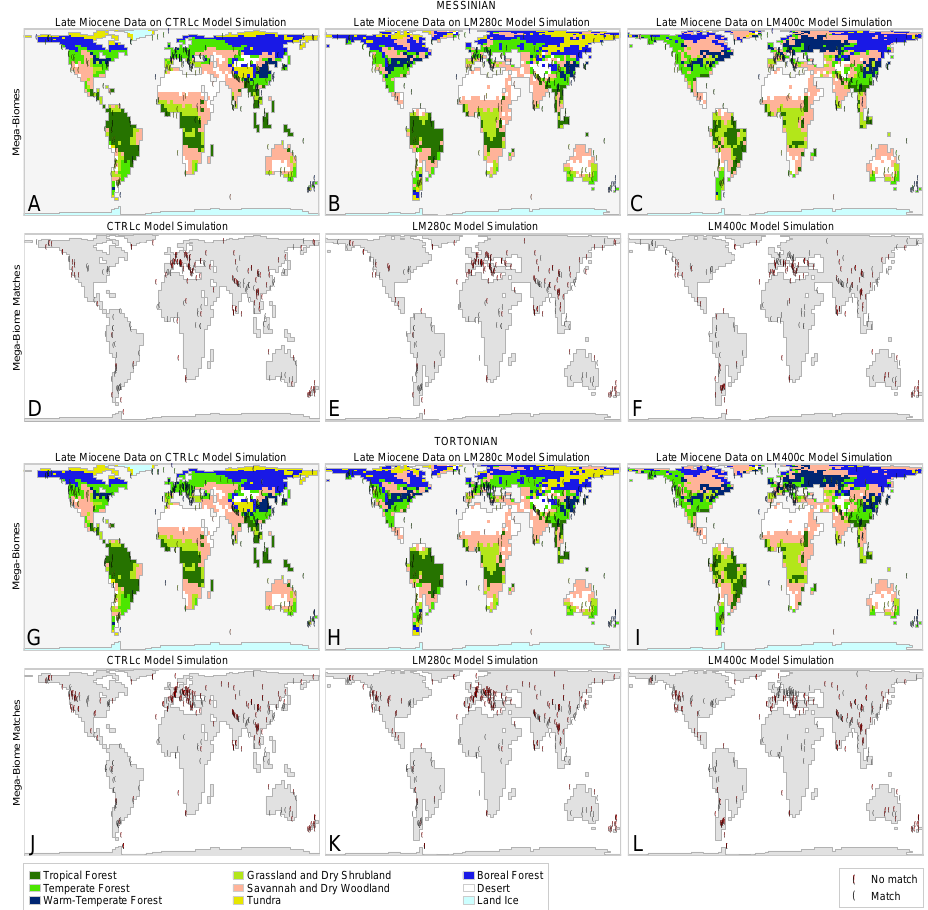
Fig. 15. Results from the model–data comparison for megabiomes: late Miocene data on CTRLc, LM280c, and